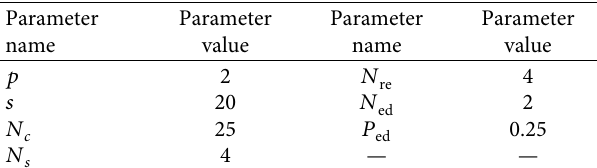
Table 2: Algorithm parameters of